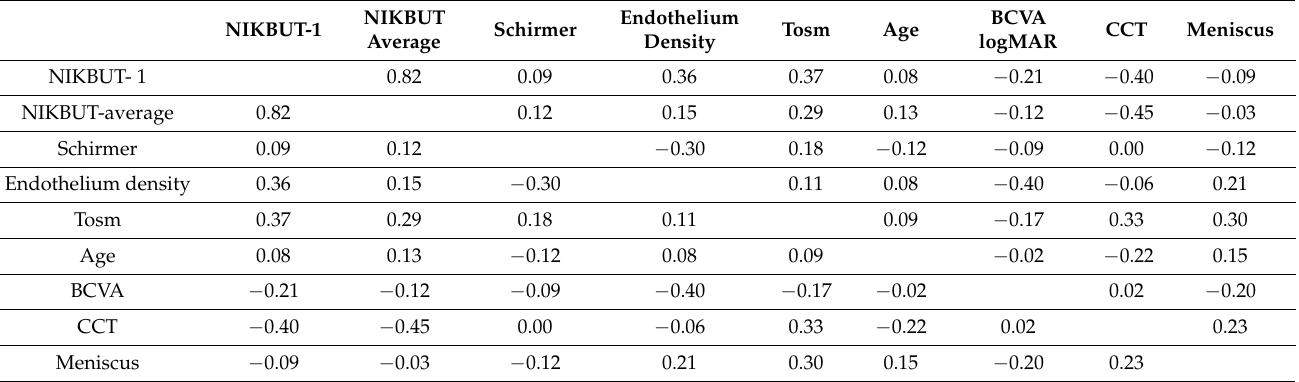
Table 3. Correlations among the control group p < 0.05 are marked